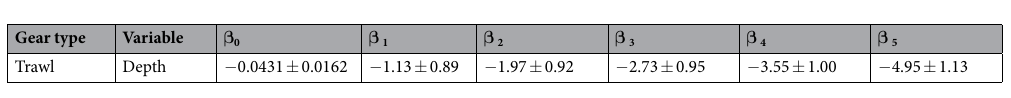
Table 3. Summary ordinal regression results for trawl bycaught turtles by severity of gas embolism based on a score ( β 1–5 ) of 0 (none) to 5 (severe).